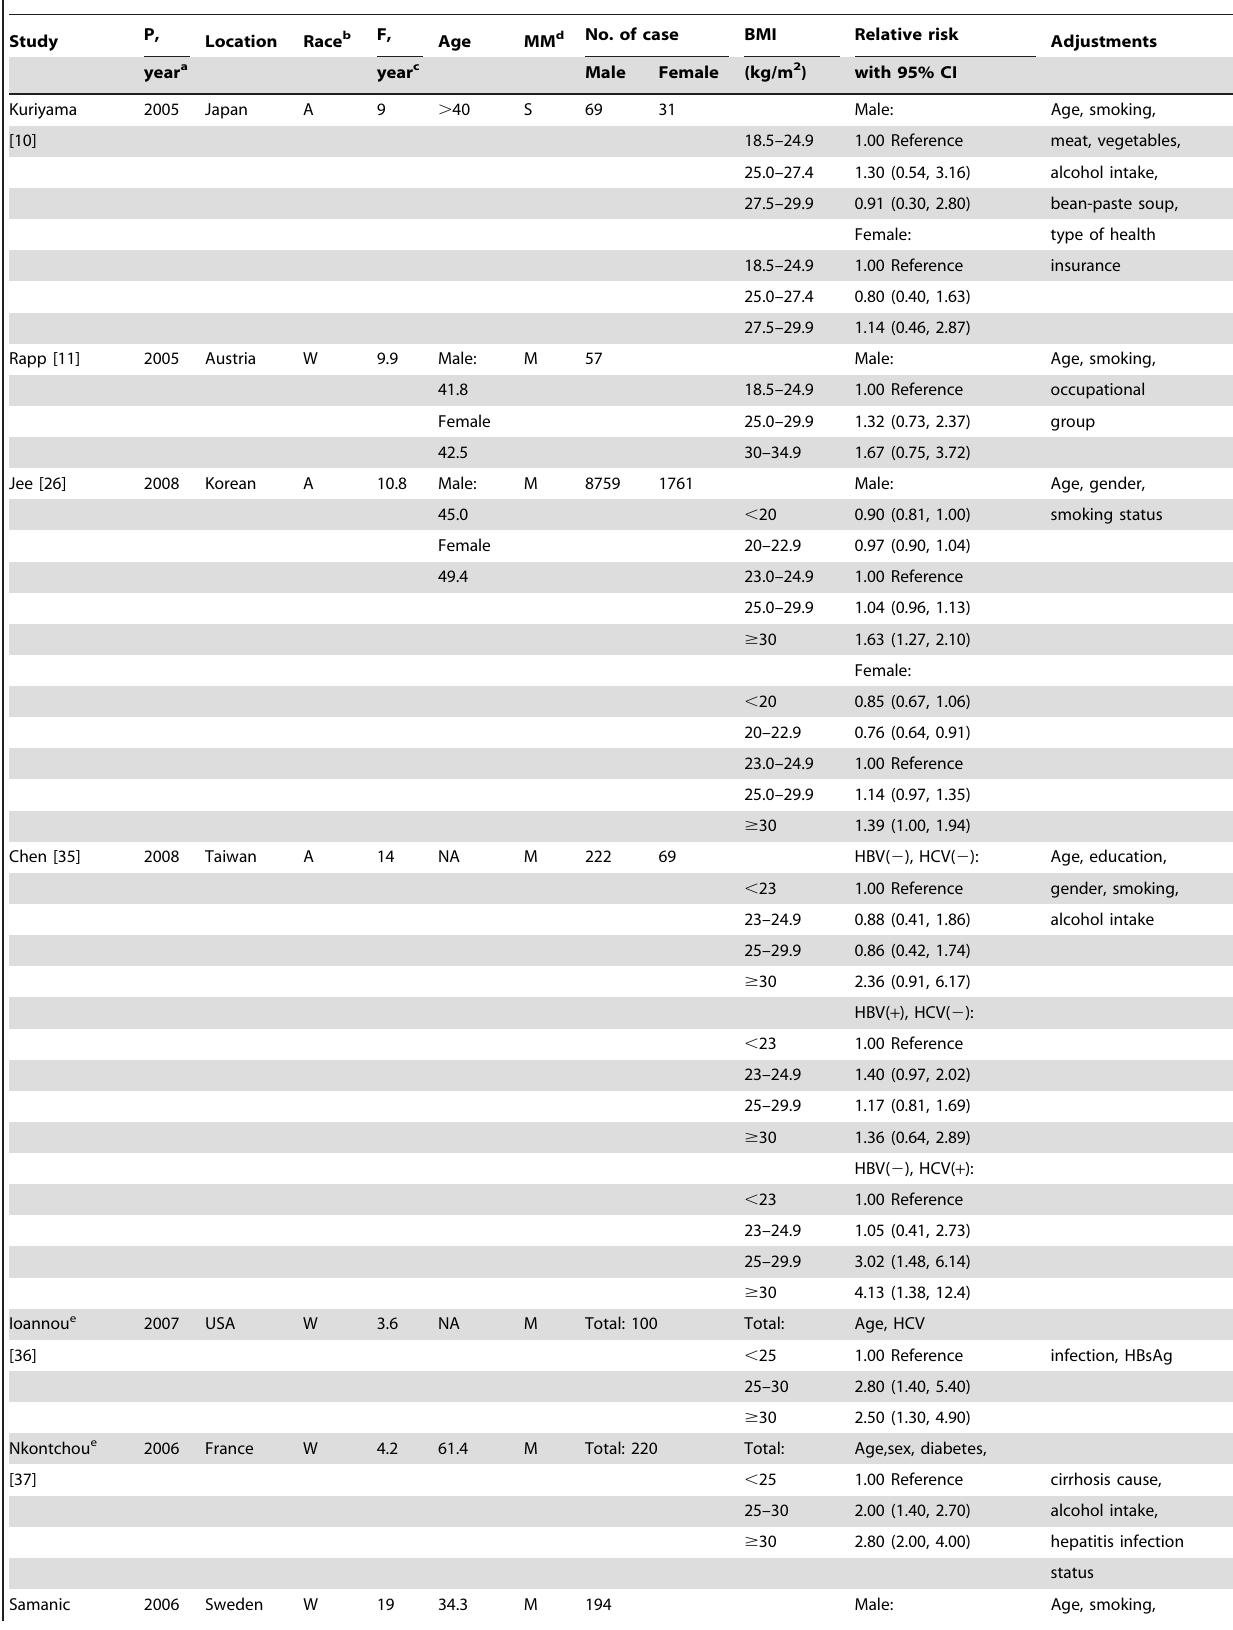
Table 1. Characteristics for prospective studies of body mass index and risk of liver cancer included in a meta-analysis.